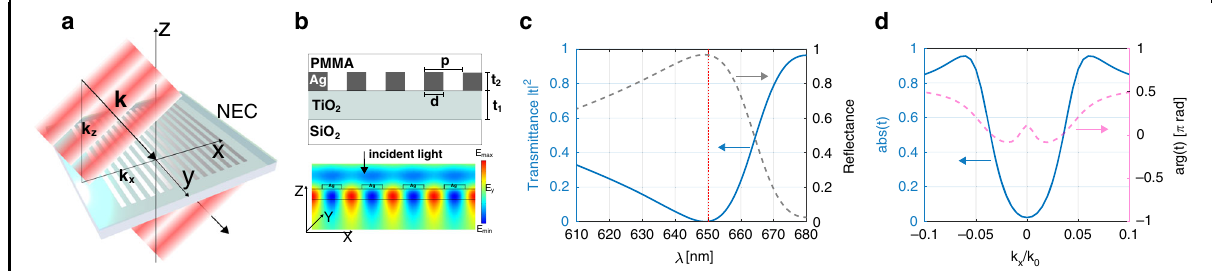
Fig. 1 The nanophotonics enhanced coverslip (NEC) and simulations of its performance. a A sketch of the NEC showing the geometry and the incident wave vectors. b A cross-section used in a FEM simulation and the calculated electric fi eld distribution ( ŷ component) for normally incident light at a wavelength λ = 650 nm, showing the standing wave induced in the waveguide. The design parameters are t 1 = 100 nm, t 2 = 40 m, d = 200 nm and p = 400 nm. c The calculated frequency response for transmission and re fl ection of normally incident light identifying the resonance at λ = 650 nm. d The calculated complex optical transfer function for s-polarised light Mð k x Þ at the resonance wavelength λ = 650 nm, expressed as a modulation transfer function Mð k x Þj j and a phase transfer function arg Mð k x